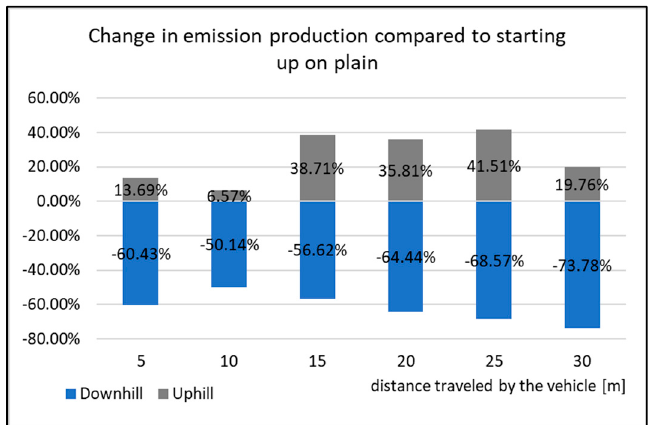
Figure 12. Cumulative value of emissions CO during measurement.